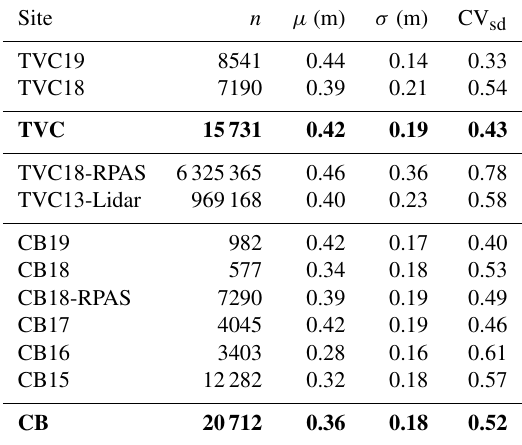
Table 4. Statistical parameters of snow depth distributions. Bold font represents multi-year average.